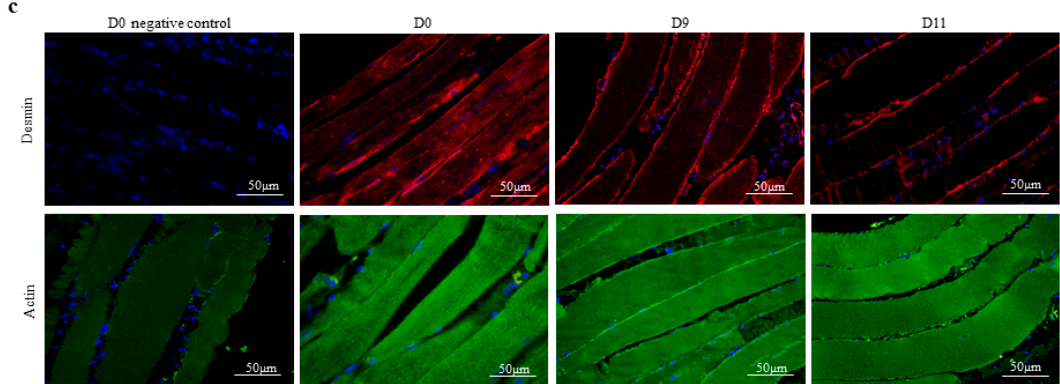
Figure 1. Human skeletal muscle tissue can be maintained under in vitro conditions. ( a ) A skeletal muscle tissue sample from a single participant (upper panel) was sectioned into multiple units that were embedded in agarose medium (lower panel). ( b ) The images from a single participant are presented and are representative of an additional seven participants. The morphological characteristics of tissue samples from the vastus lateralis muscle of individual participants were analyzed in longitudinal and cross sections by HE staining immediately after surgery (D0) or after 9 or 11 days of maintenance in vitro (D9 or D11, respectively). ( c ) Parallel sets of tissue sections from the gluteus medius muscle at D0, D9, and D11 were analyzed, and the morphological integrity of muscle fibers was compared using antibodies against desmin (upper panel) or actin (lower panel) for immunofluorescence staining, with DAPI used as a counterstain. Additional sections were analyzed without the addition of desmin or actin antibodies as a negative control (D0 negative control). Images of tissue from a single participant are shown and are representative of the other seven participants. The white scale bars represent 50 µm.